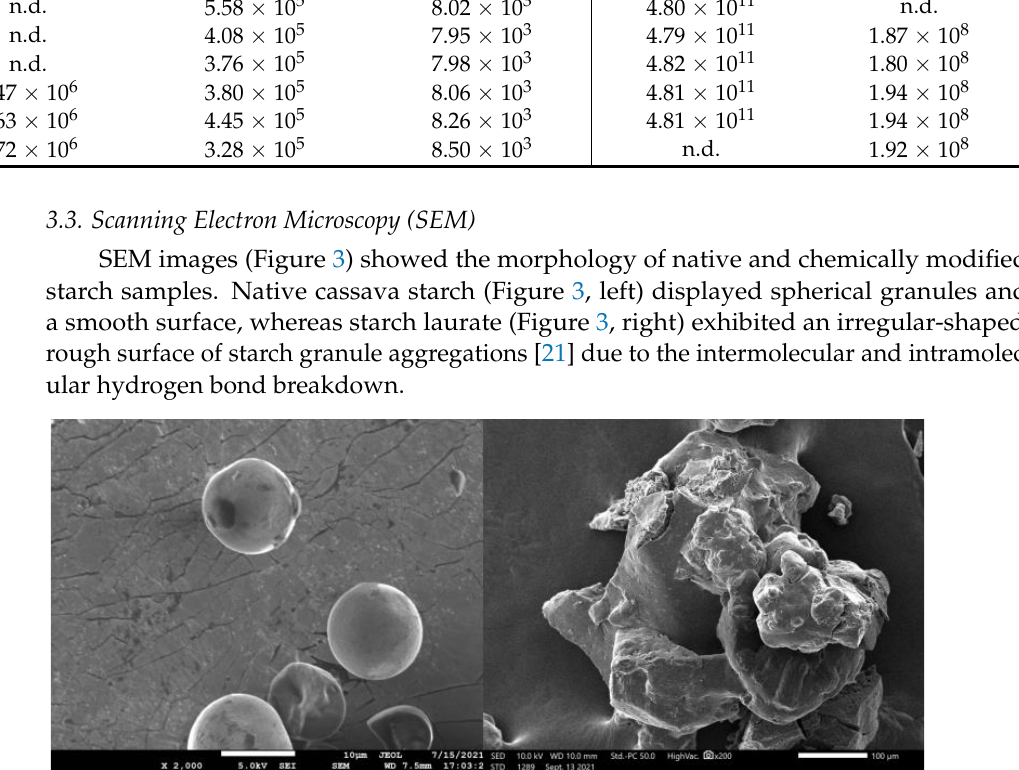
Table 1. Molecular weight (M w ) of cassava starch and starch laurates in water and DMSO solvents (n.d. = not detected).